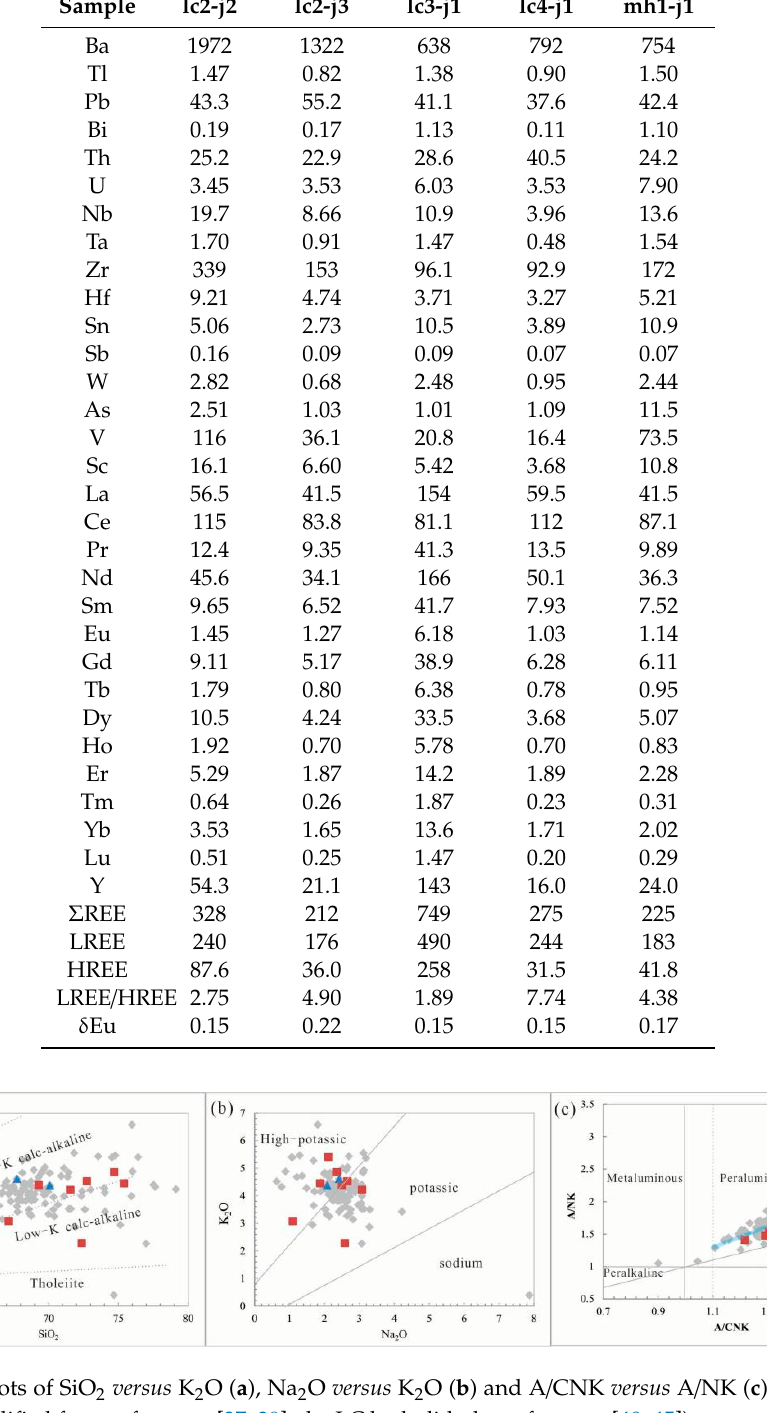
Fig.5 Discrimination diagrams for the genetic types of the Lincang granite Fig.6 Harker diagrams for the major elements in the Lincang